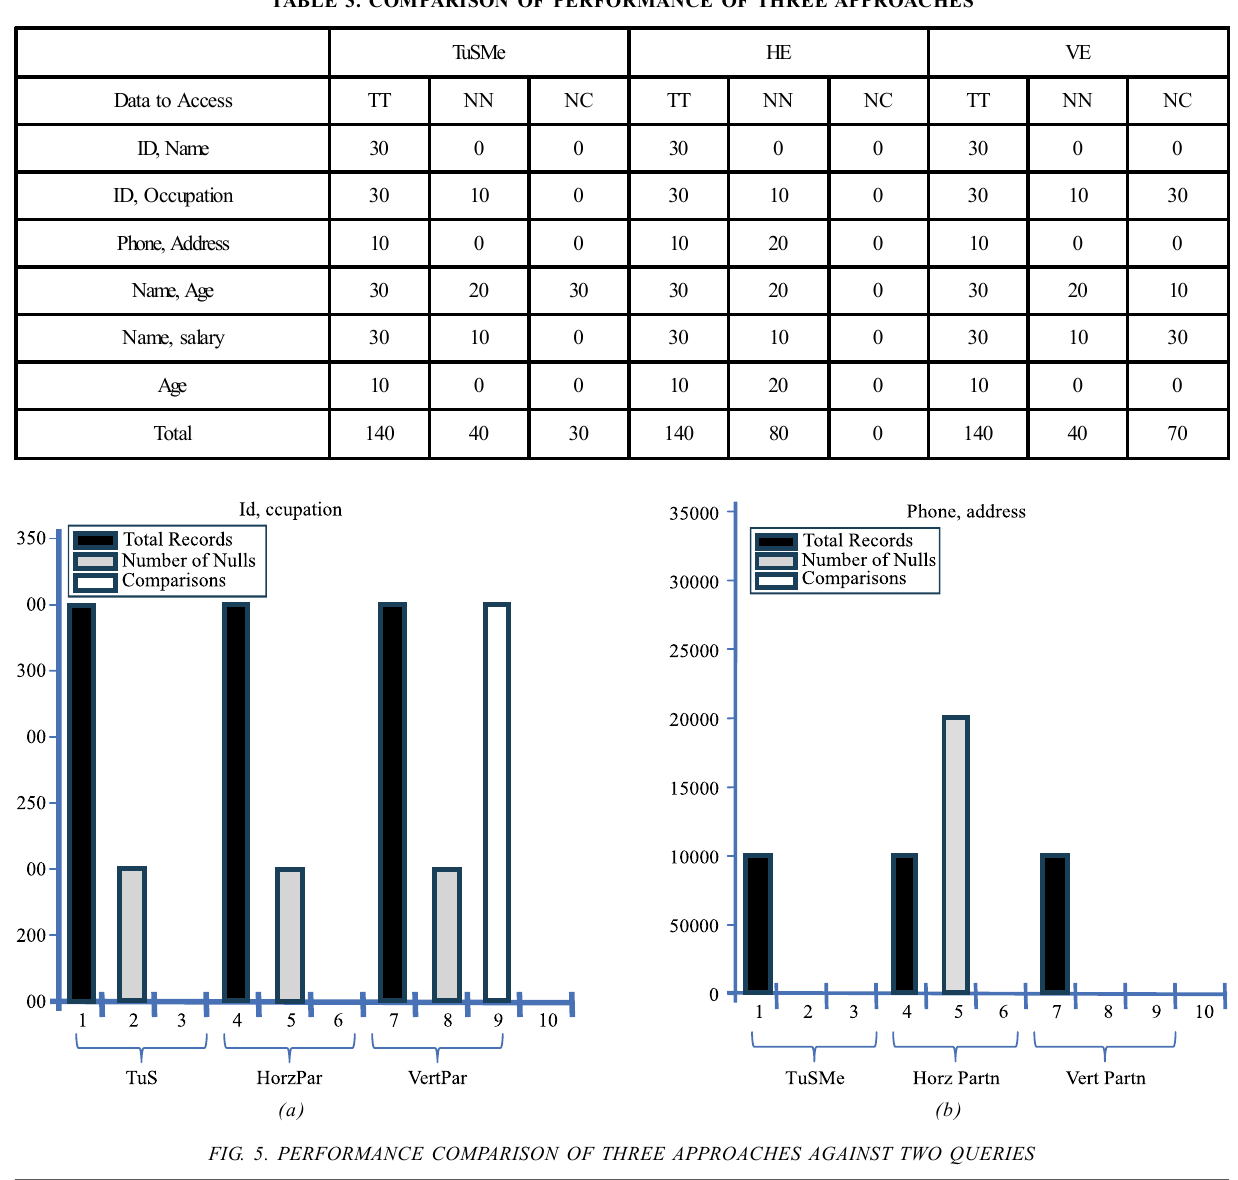
TABLE 3. COMPARISON OF PERFORMANCE OF THREE APPROACHES